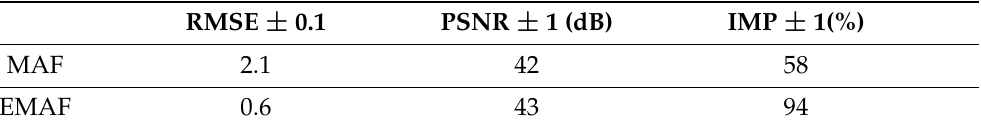
Table 3. Comparison between Picard’s MAF and EMAF